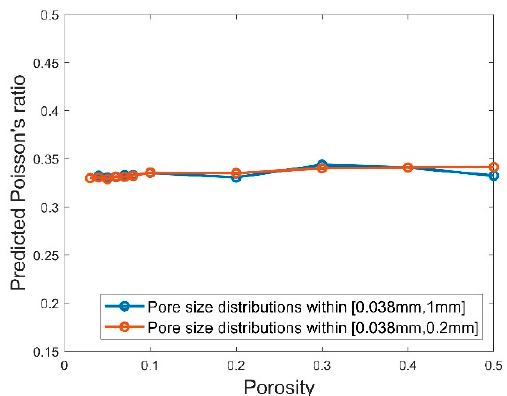
Figure 15. Predicted Young’s modulus against the porosity for the RVEs using pore size distributions within [0.388 mm, 0.2 mm] and [0.388 mm, 1